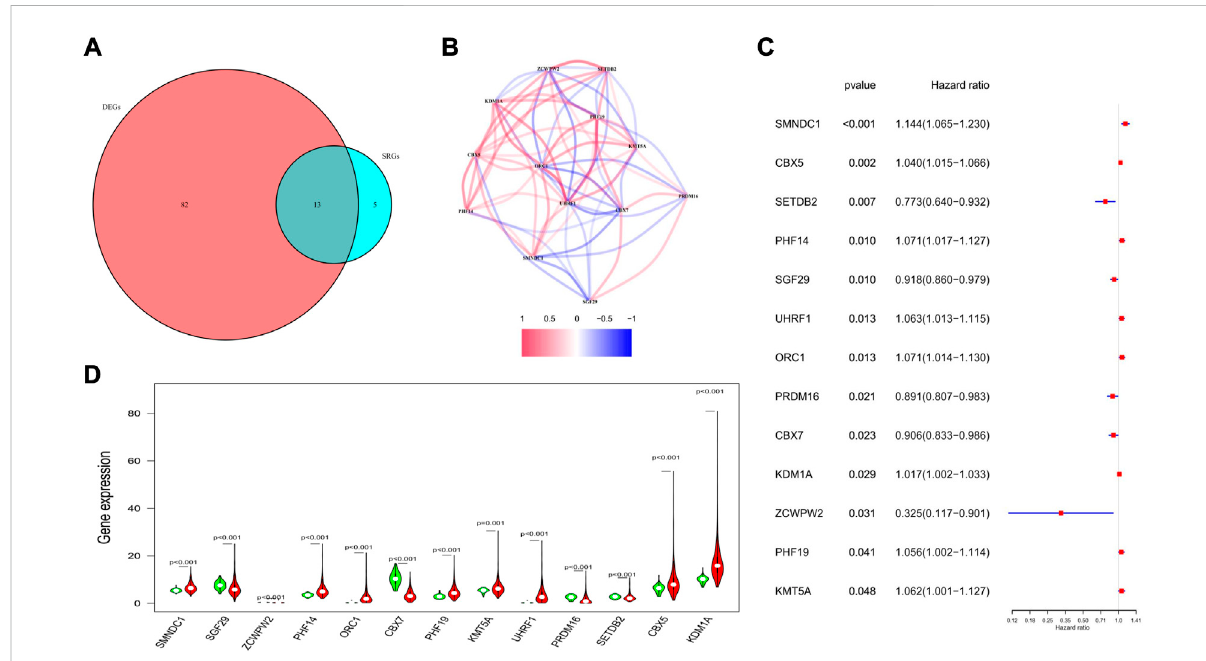
FIGURE 4 Characteristicsofthe13candidategenes. (A) VenndiagramshowingtheintersectiongenesbetweenDEGsandSRGs. (B) Spearmancorrelation analysis for the 13 genes (red, positive correlations; blue, negative correlations). (C) Forest plot showing the prognostic value of the 13 genes. (D) Violin plot showing the expression levels of the 13 genes between normal (green) and tumor tissues